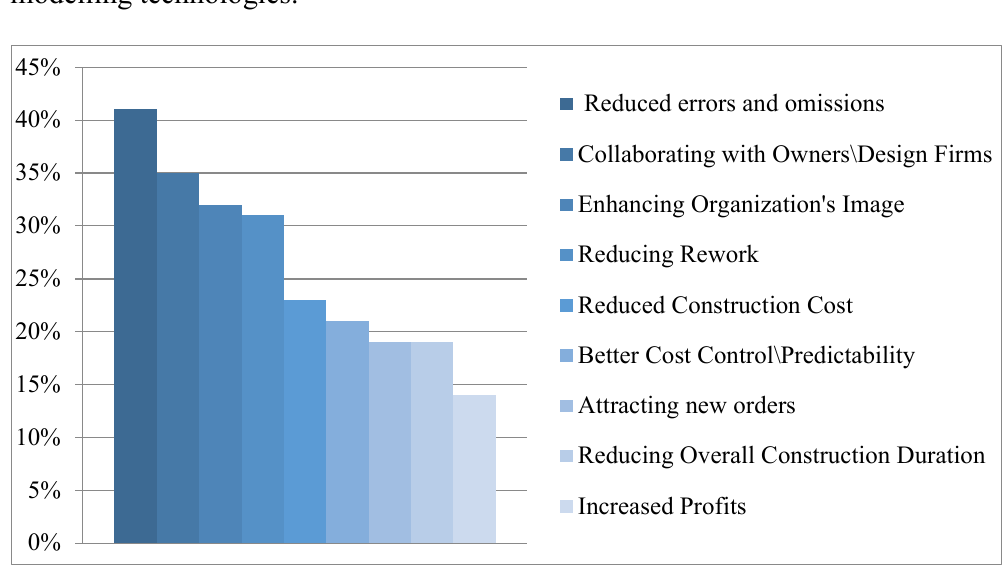
Fig. 2. Criteria determining BIM effectiveness in construction companies of Northern America, % (McGraw Hill Construction,